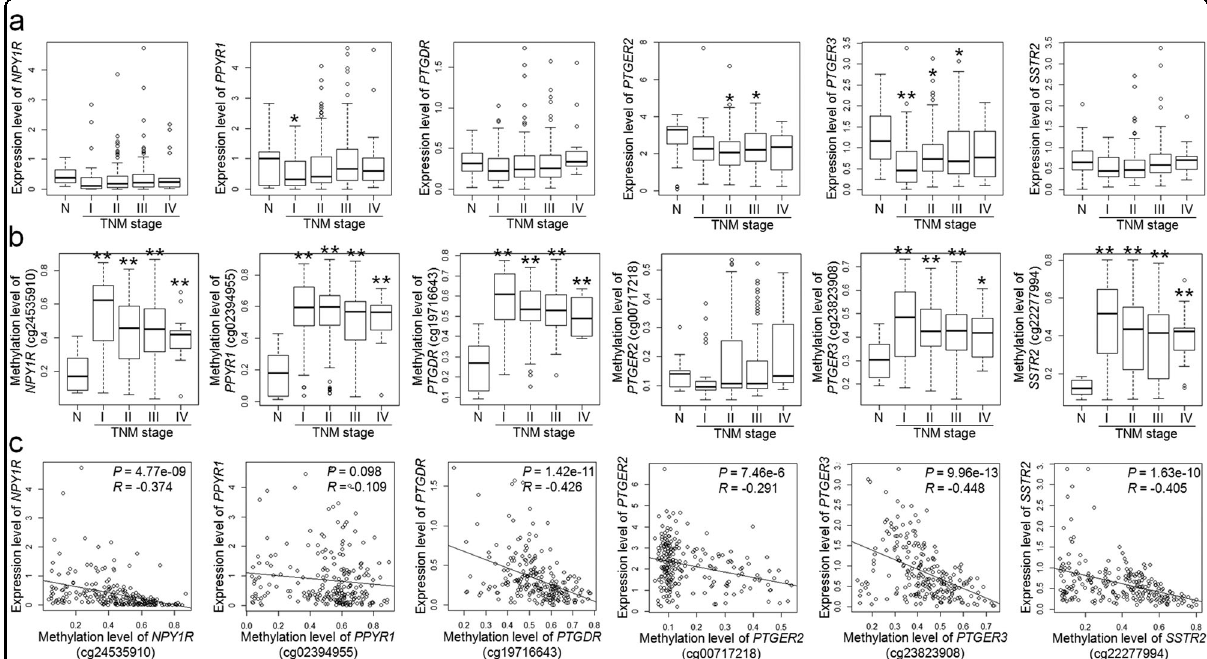
Fig. 6 Methylation and expression analysis of six hypermethylated genes in the TCGA database. a Expression analysis of each gene in gastric normal tissues ( n = 29) and gastric tumors by TNM stages (stage I, n = 47; II, n = 108; III, n = 99; and IV, n = 18) from TCGA database using RNA-seq. b Methylation analysis of each gene in gastric normal tissues ( n = 13) and gastric tumor by TNM stages (stage I, n = 26; II, n = 110; III, n = 98; and IV, n = 14) from TCGA database using an In fi nium Human Methylation 450 BeadChip. Statistical analysis of ( a ) and ( b ) were performed by t -test at P < 0.05 (*) or P < 0.001 (**) compared to normal gastric tissues. c Negative correlation between gene expression (RNA-seq) and promoter methylation (450K array) of each gene in gastric tumors ( n = 230) from TCGA database. Statistical analysis was performed by Pearson ’ s correlation test